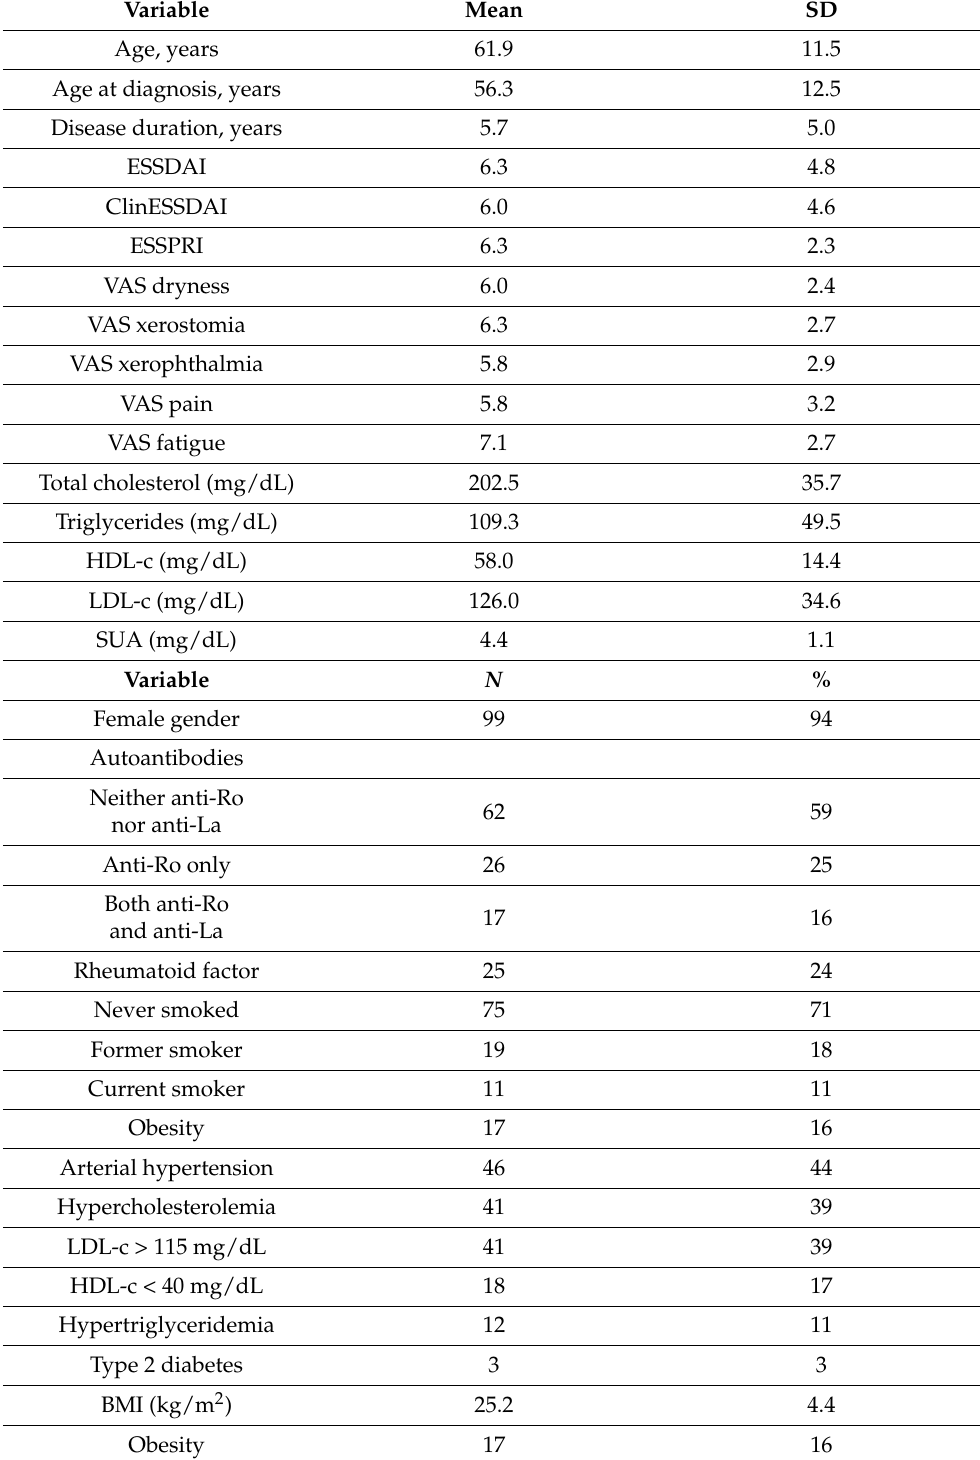
Table 1. Characteristics of the study cohort ( N =